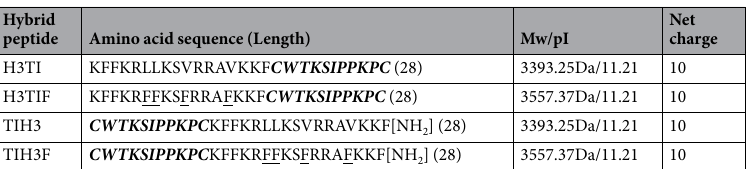
Hybrid peptide Amino acid sequence (Length)